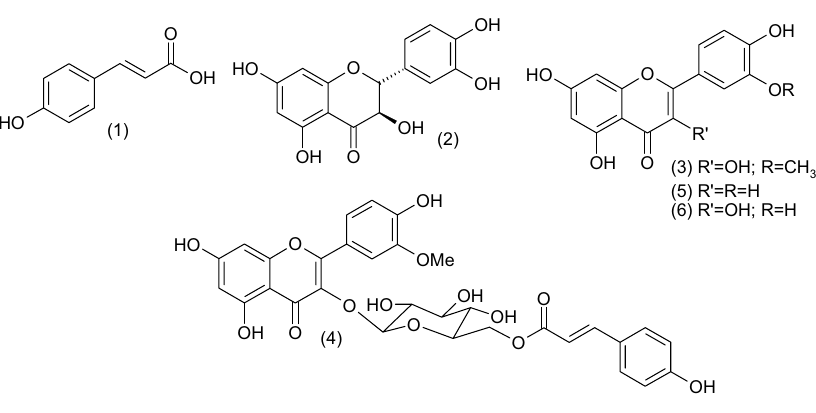
Fig. 1 – Compounds isolated from the pollen loads of stingless bee Melipona rufiventris